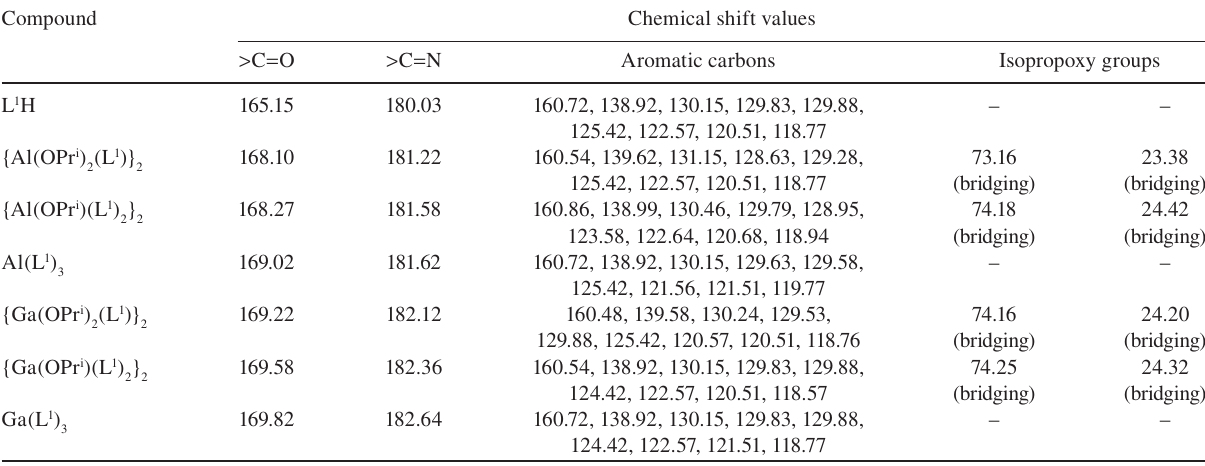
Table 2 13 C NMR spectral data ( δ ppm) of L 1 H and its aluminum(III) and gallium(III) complexes.